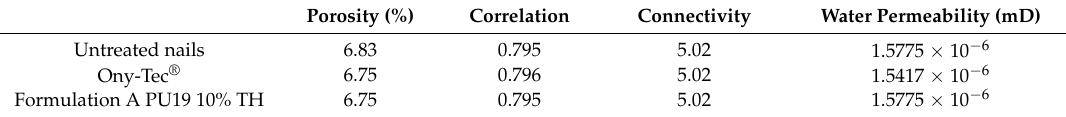
Table 7. Main parameters of the models obtained from porosity data using PoreXpert™. Porosity